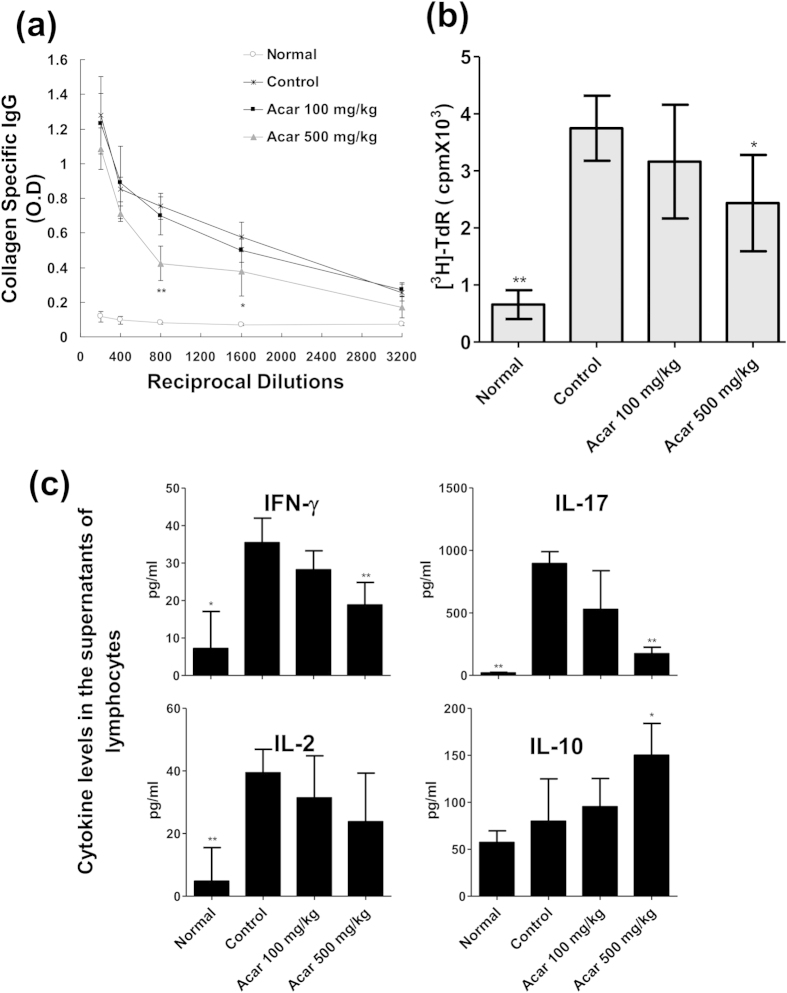
Collagen type II (CII)-specific autoantibody production in serum and in vitro CII-induced lymph node T cells expansion and cytokine production in the following four groups of mice (n = 5 in each group): normal mice, and collagen II-immunized mice treated with water (control), low-dose acarbose (100 mg/kg/day) mice, and high-dose (500 mg/kg/day) acarbose.(a) The IgG reactivity to CII in serum tested at different dilutions (in two-fold steps from 1:200 to 1:3,200) by enzyme-linked immunosorbent assay (ELISA). Serum from normal DBA/1 mice, control and acarbose (100 mg/kg/day or 500 mg/kg/day)-treated CIA mice were precipitated. CII-reactive IgG within serial dilutions of serum precipitates were determined in triplicate by ELISA. The values show the mean ± standard deviation (SD) of the optical density at 450 nm (OD450). (b) Inguinal lymph node cells (5 × 105 cells/100 μl per well) from each group of mice were cultured in triplicate in media containing 40 μg/ml CII for 64 hr. And then there was pulsing with 1 Ci [3H]thymidine for another 18 hr. The cell proliferations assay was measured by the [3H]TdR incorporation assay. The values show the mean ± SD counts per minute (c.p.m.). (c) Regarding the in vitro cytokine analysis, inguinal LN cells (5 × 105 cells/100 μl per well) of different mice groups were stimulated at 40 μg/ml CII under the same conditions used for the proliferation assay. After 48 h, the culture supernatants were collected, and IL-17, IFN-γ, IL-2, and IL-10 production were measured in the triplicate well by ELISA. The values revealed that the mean ± SD optical density at 450 nm (OD450). All experiments were repeated 3 times, and data are representative of 3 independent experiments with similar results. *p < 0.05; **p < 0.01, vs. controls.